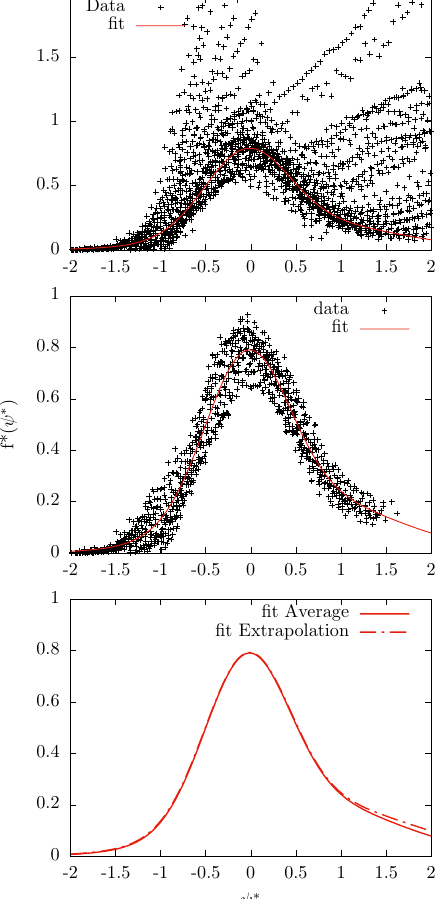
Figure 2. Super scaling analysis with relativistic effective mass (SuSAM*) of 12 C data. Top panel: experimental scaling data f ∗ exp plotted against ψ ∗ . Middle panel: data surviving after cleanup of non-quasielastic sparse points. The red curve is Gaussian fit made in this work, f ∗ bottom panel, we compare the two scaling functions obtained with two different definitions of the averaged single-nucleon responses: using the extrapolated Fermi gas responses and performing the average with a Fermi distribution defined in Section